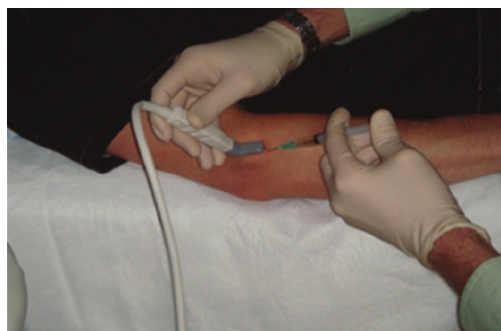
Figure 6: Injection of lateral epicondyle under ultrasound guid-